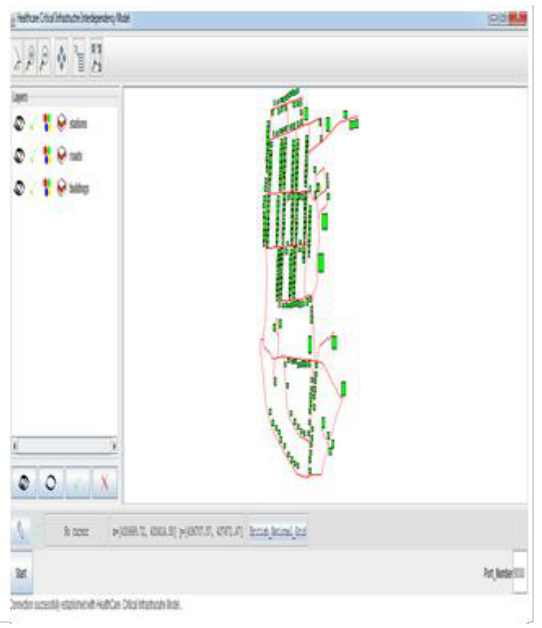
Figure 9. Healthcare SCPN model Connection with the GIS